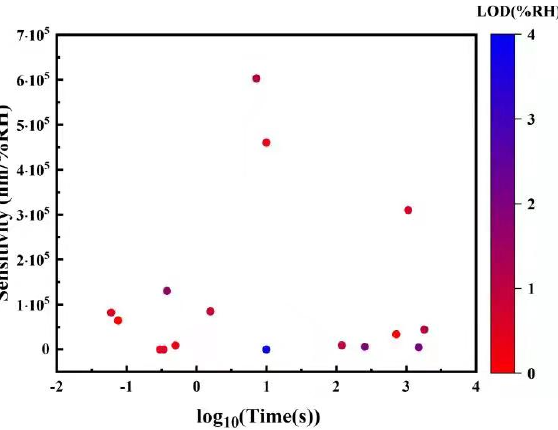
Figure 41. Relationship between log scale of time and sensitivity, with color representing limit of detection.